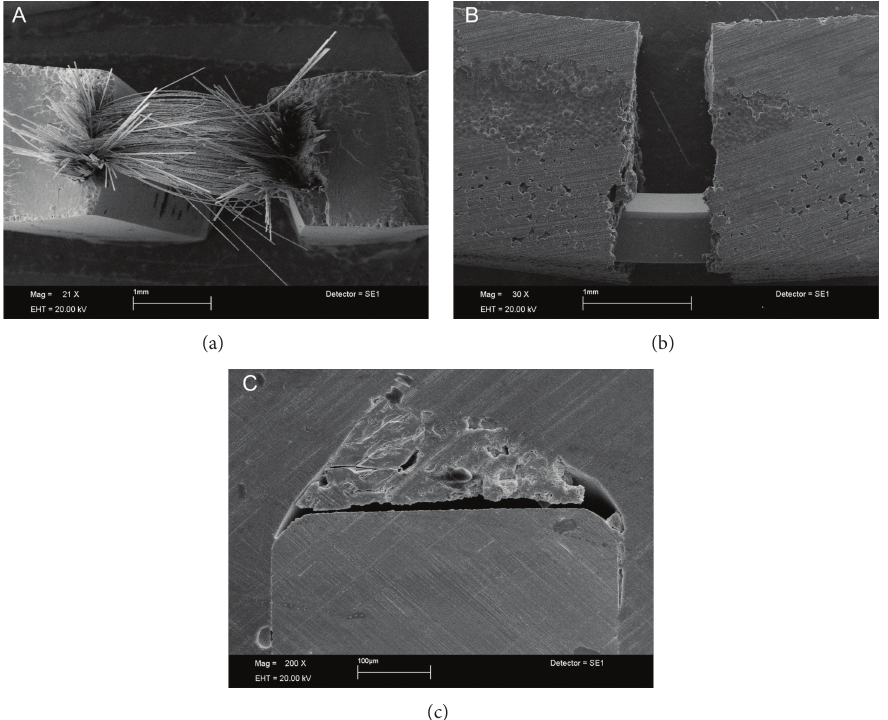
Figure 2: Fiber rupture and metal dislodgement within acrylic resins. (a) Unidirectional glass fibers in self-polymerized resin showing partial fiber rupture ( × 21 magnification). (b) Intact steel wire with resin fracture and separation: metal smooth surfaces did not micromechanically interlock with heat-polymerized resin ( × 30 magnification). (c) Tensile side of specimen with steel wire and self-polymerized resin ( × 200 magnification). In spite of observed spaces, wire’s lateral surfaces showed close interaction with resin, providing greater reinforcement.